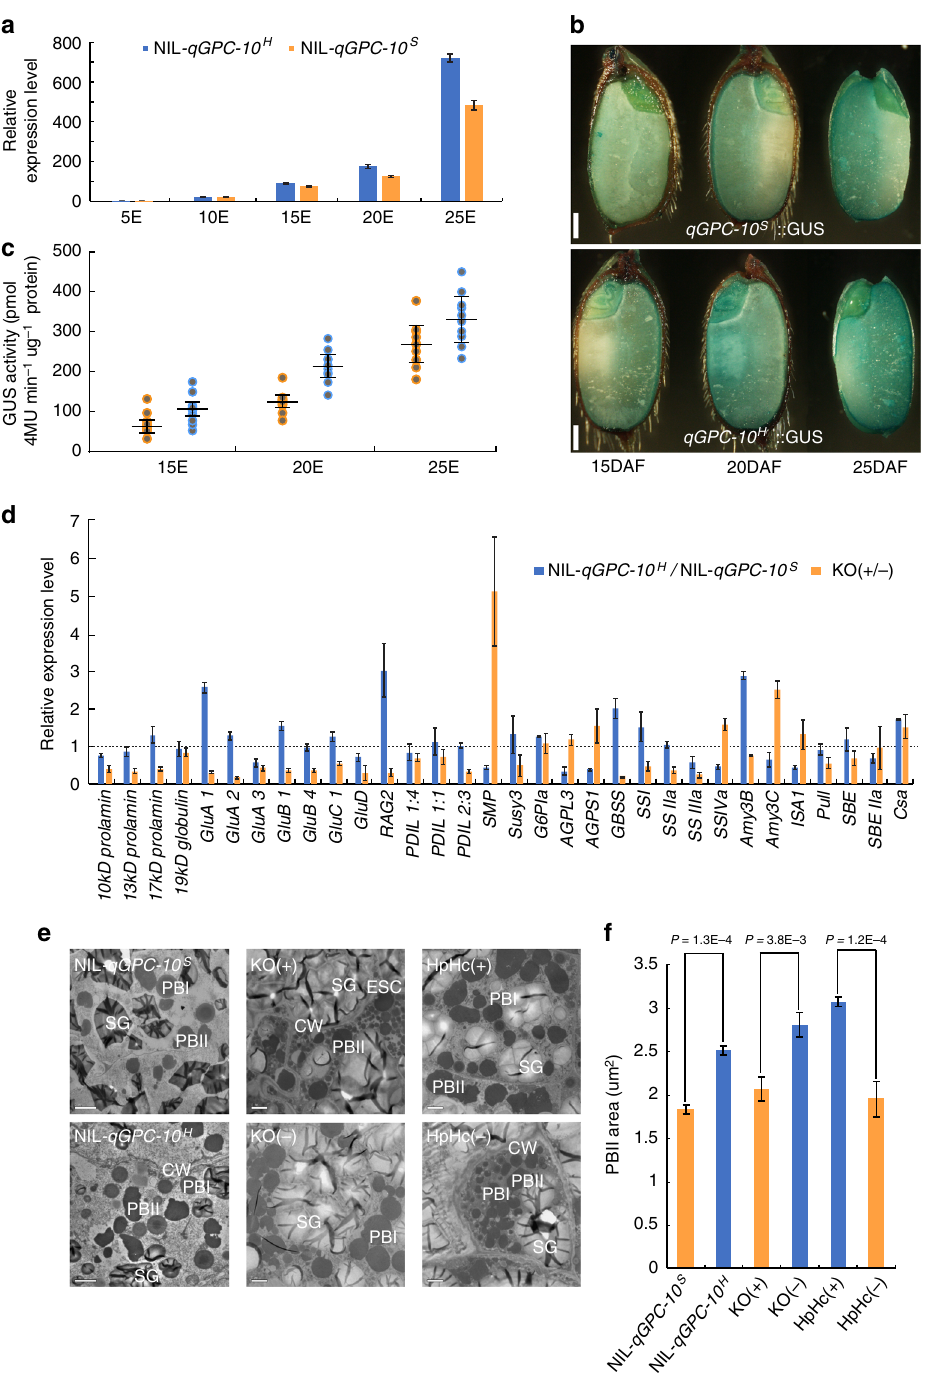
Fig. 3 The expression patterns of OsGluA2 and genes involved in storage materials. a The expression patterns of OsGluA2 was determined by qRT-PCR. 5E, 10E, 15E, 20E, and 25E: endosperms at 5, 10, 15, 20, and 25 DAF. n = 3. b GUS assays in transgenic rice carrying qGPC-10 S ::GUS and qGPC-10 H ::GUS at 15, 20, and 25 DAF. Scale bar = 1 mm. c GUS activity in maturing seeds at 15, 20, and 25 DAF. GUS activity is expressed as pmol 4MU min − 1 μ g − 1 protein. n = 10. d Expression levels of key genes involved in synthesis and storage of endosperm components in T 2 transgenic plants and NILs. Transgene-positive plants of OsGluA2 and NIL- qGPC-10 H are shown relative to transgene-negative plants and NIL- qGPC-10 S , respectively, set as 1. Error bars, s.d., n = 3. e Ultrastructure of cells in developing endosperm of NILs and transgenic plants in 15 DAF. PB I and PB II protein bodies I and II, SG starch granule, ECS extracellular space, CW cell wall. Scale bars = 2 μ m. f Quantitative comparison of PB II area in NILs and transgenic plants. P -values were calculated by independent-samples t -test. Error bars, s.d., n = 3. Source data of Figs. 3a, 3c, 3d and 3f are provided as a Source Data fi